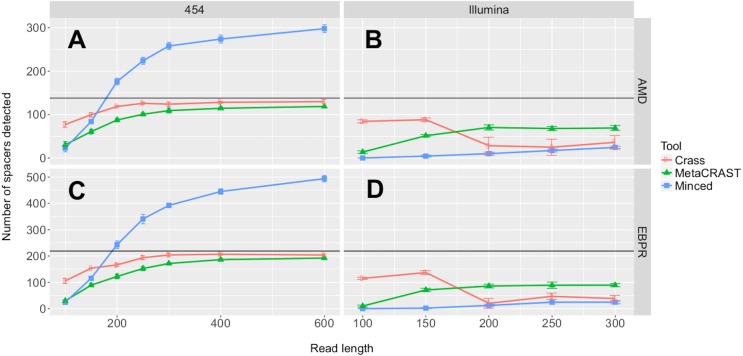
Evaluation of MetaCRAST, Crass, and MinCED performance on simulated AMD (A and B) and EBPR (C and D) metagenomes.The procedure used to generate the simulated metagenomes is described in Materials and Methods. All data points represent the averages of six individual simulations and are presented with error bars representing two times the standard error above and two below the average. The true number of spacers expected in each simulated metagenome is marked with a black line (138 expected in the AMD metagenomes; 219 in the EBPR metagenomes).